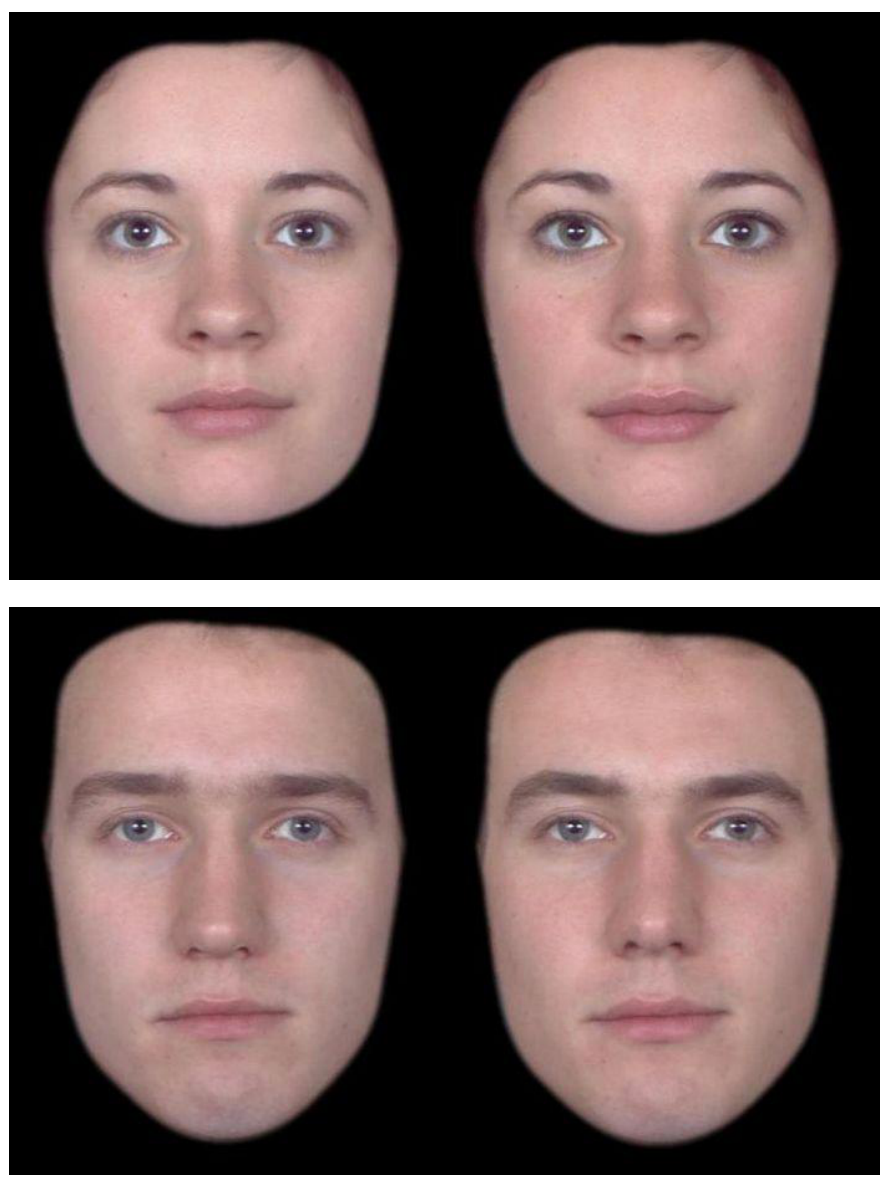
Figure 1 . Examples of less healthy (left) and more healthy (right) appearing female and male